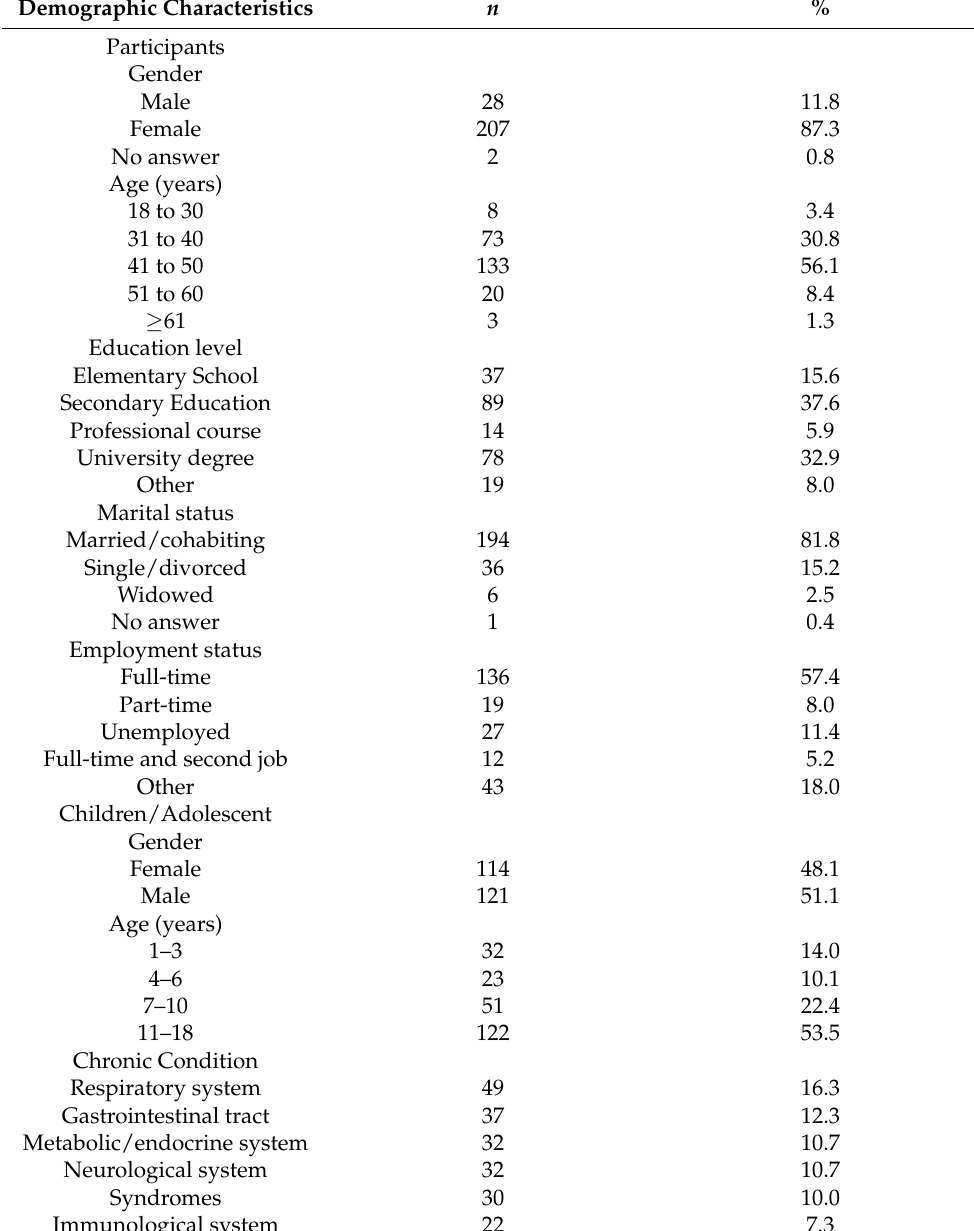
Table 1. Descriptive characteristics of the sample ( n =